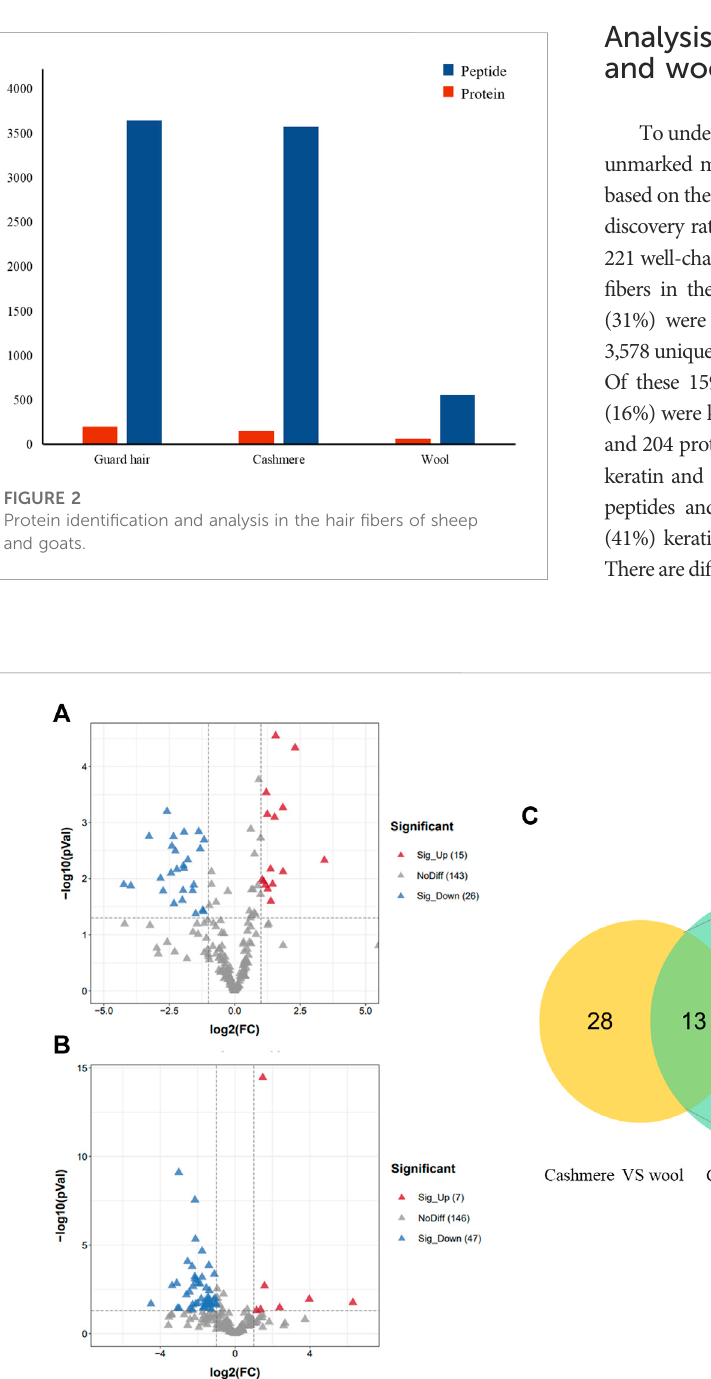
FIGURE 3 Differentially expressed proteins (DEPs) between sheep and goats. (A) . Volcano plot of distribution trends for DEPs between cashmere and wool. (B) .VolcanoplotofdistributiontrendsforDEPsbetweenguardhairandwool. (C) .TheVenndiagramshowsdifferentiallyexpressed proteinsin common between the two groups in this